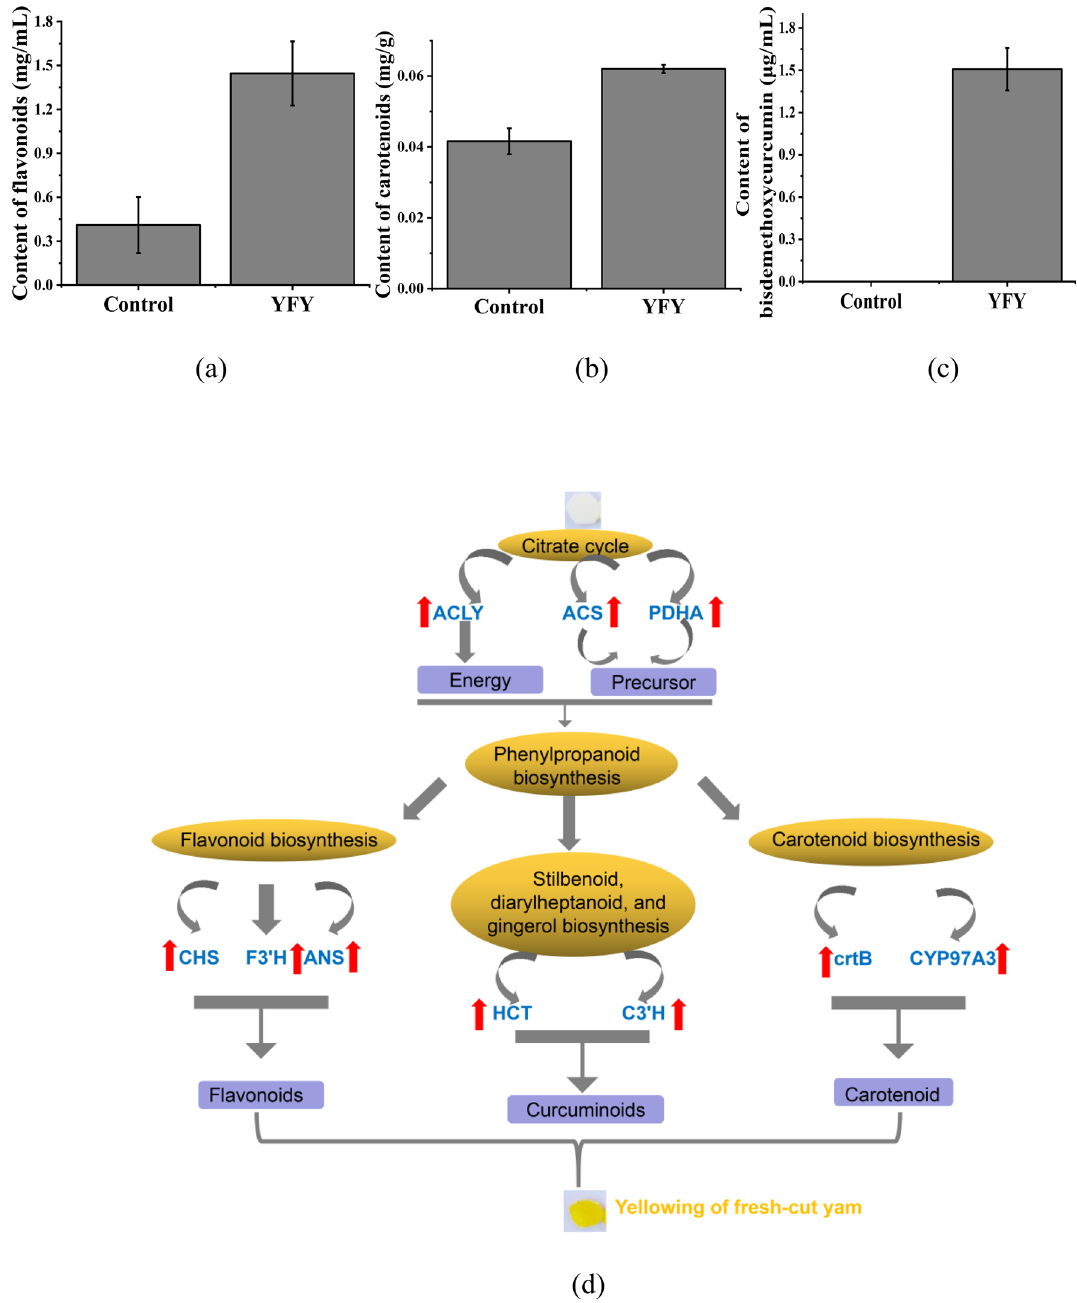
Figure 7. ( a ) Content of total flavonoids. ( b ) Content of total carotenoids. ( c ) Content of bisdemethoxycurcumin. ( d ) Hypothetical mechanism for the yellowing of fresh-cut